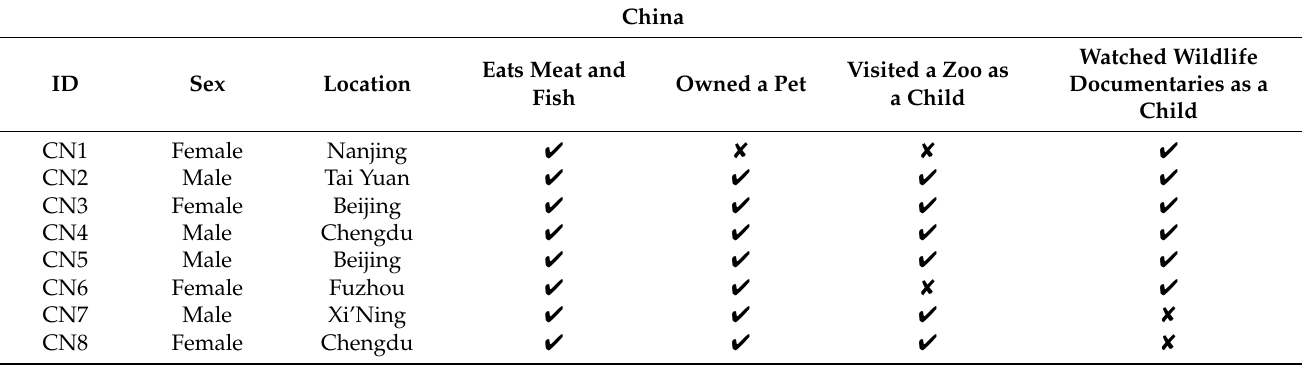
Table 2. Anonymised demographic characteristics of interviewees in China. CN = China), numbers 1–8 in chronological order of interview. (cid:52) represents an affirmative response to the survey item whilst (cid:56) represents a negative response. China